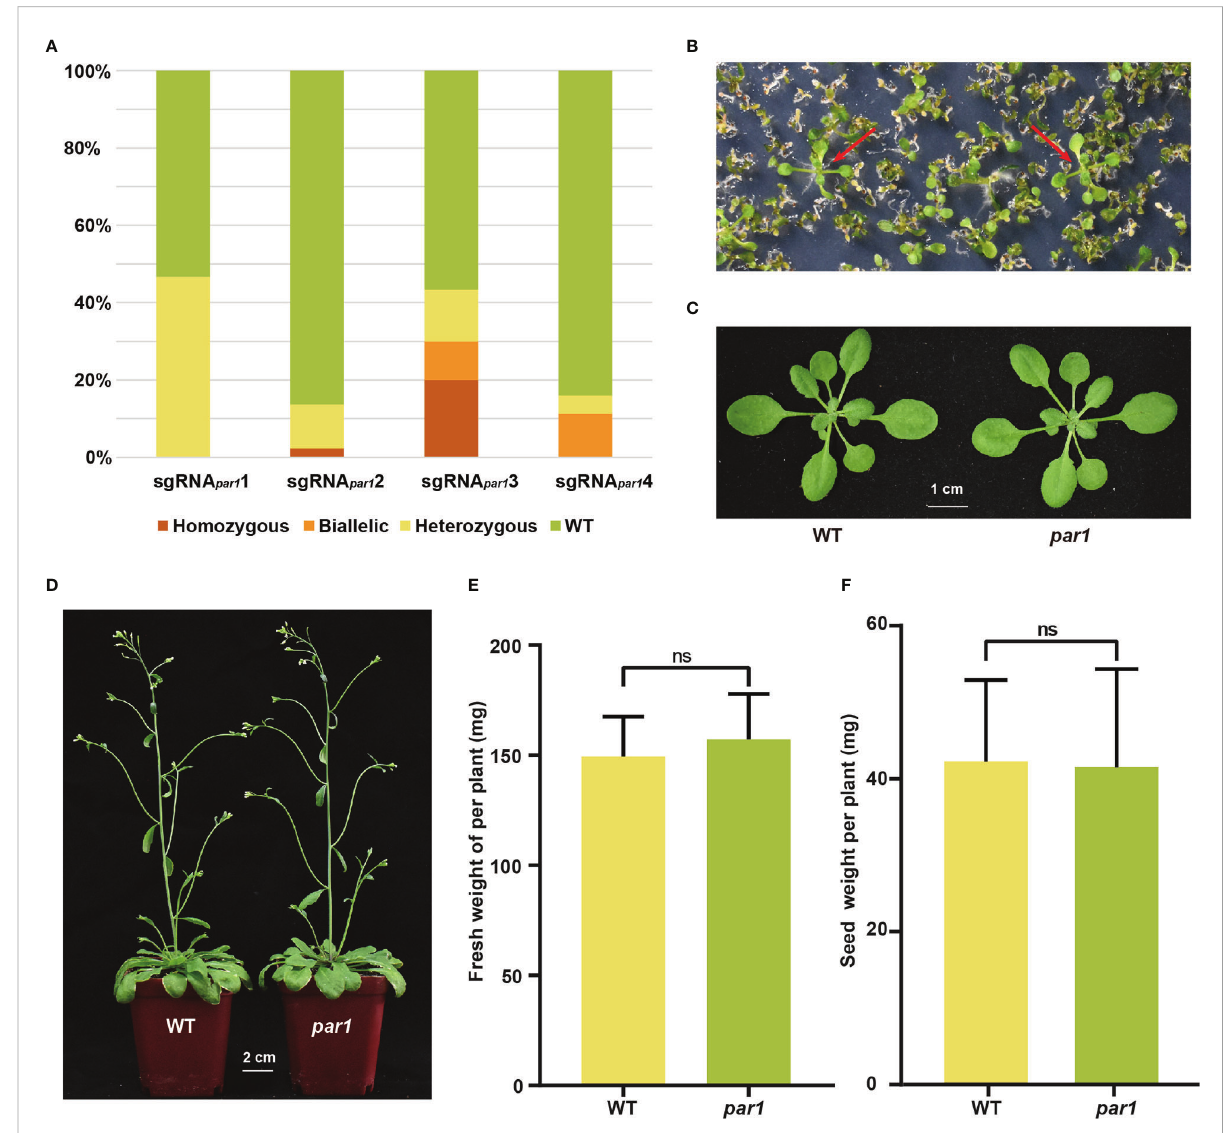
FIGURE 2 PAR1 is a suitable selection marker for transgene-free gene edited plants. (A) Percentages of WT and different types of mutations at four sgRNA PAR1 target loci among their T1 plants. (B) Selection of the par1 mutant on 1/2 MS medium supplemented with 1 m M paraquat. The large and green seedlings indicated by red arrows are paraquat-resistant seedlings. (C) Representative three-week-old WT and par1 mutant plants. (D) Representative six-week-old WT and par1 mutant plants. (E) The fresh weight per plant of WT and par1 mutant ( n = 20) growing in soil with a 12 h light/12 h dark photoperiod at 22°C for three and a half weeks. (F) Seed weight per plant for WT and the par1 mutant ( n = 30). Data are shown as mean ± SD. ns, no signi fi cant